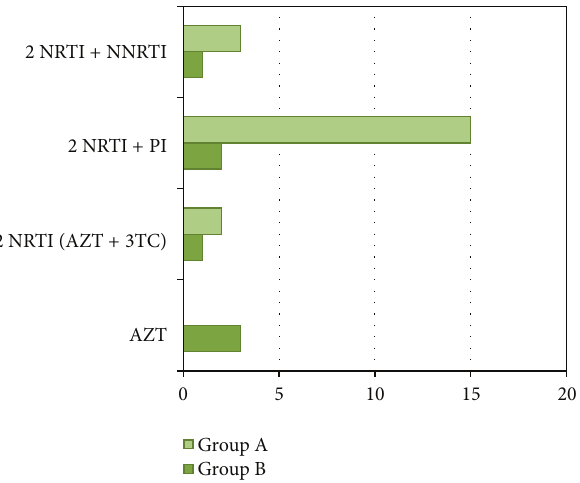
Figure 2: Antiretroviral therapy during pregnancy. AZT: zidovu- dine; 3TC: lamivudine; NRTI: nucleoside reverse transcriptase inhibitors; NNRTI: nonnucleoside reverse transcriptase inhibitors; PI: protease